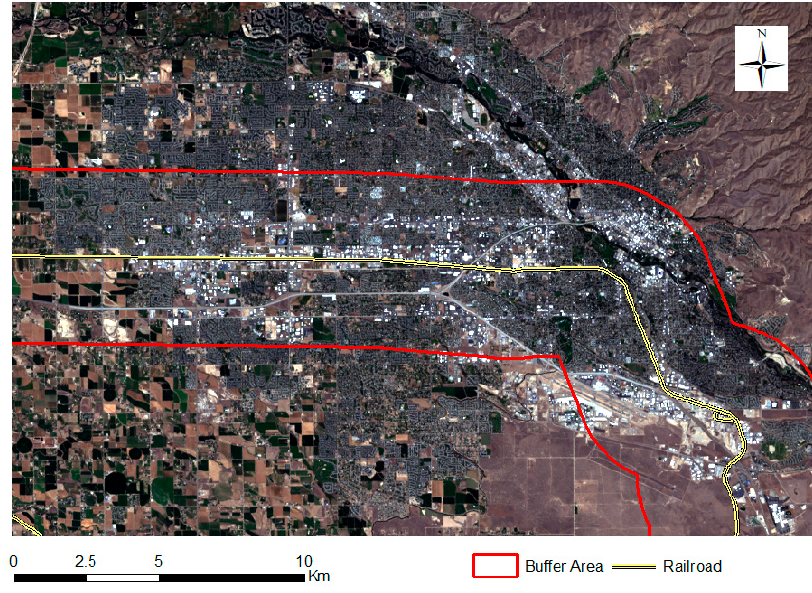
Figure 8. Satellite image of the Boise-Meridian metropolitan area in 2013 showing the urban development along the railroads.